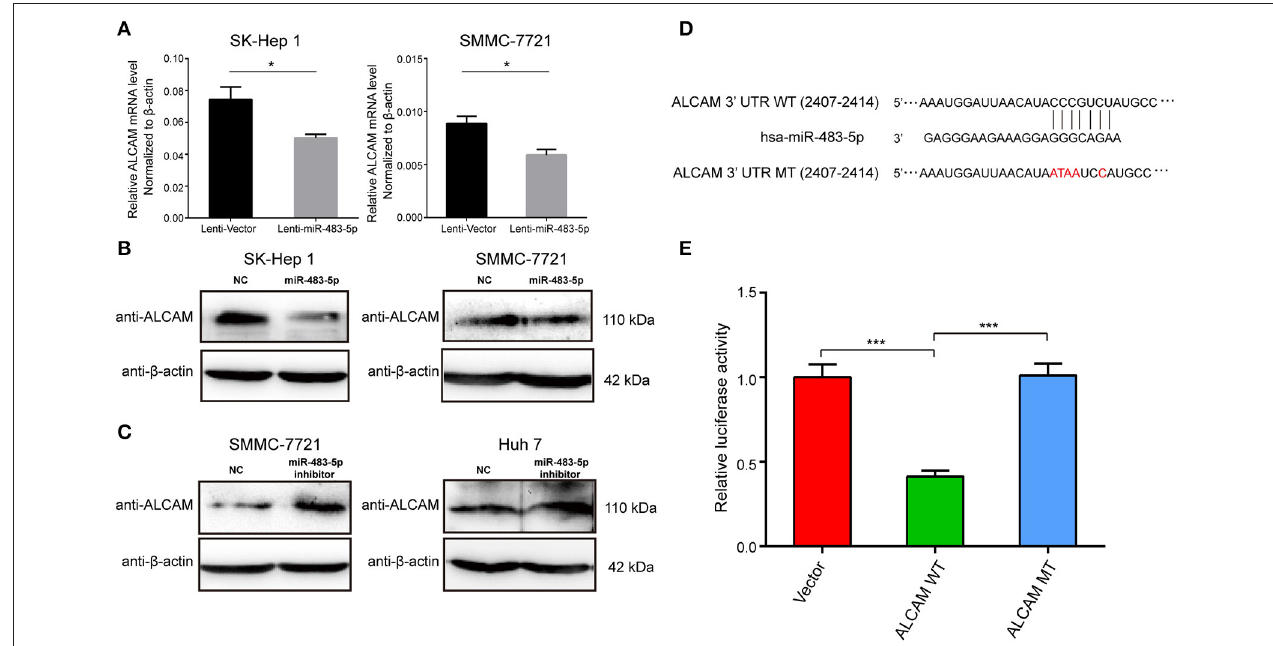
FIGURE 4 | miR-483-5p post-transcriptionally downregulates ALCAM expression by directly targeting its 3 ′ -UTR. (A) ALCAM mRNA levels were repressed by miR-483-5p in HCC cells. (B) ALCAM protein levels were repressed by miR-483-5p mimics in HCC cells. (C) ALCAM protein levels were up-regulated in HCC cells with miR-483-5p inhibitor. (D) Diagram of putative miR-483-5p binding sites in the 3 ′ -UTR of ALCAM. The mutant sequences ALCAM 3 ′ -UTR used in the luciferase reporter constructs are indicated in red. (E) Relative activities of luciferase reporters containing ALCAM 3 ′ -UTR variants co-transfected with miR-483-5p or negative control mimics in HEK 293T cells. * p < 0.05; *** p < 0.001.